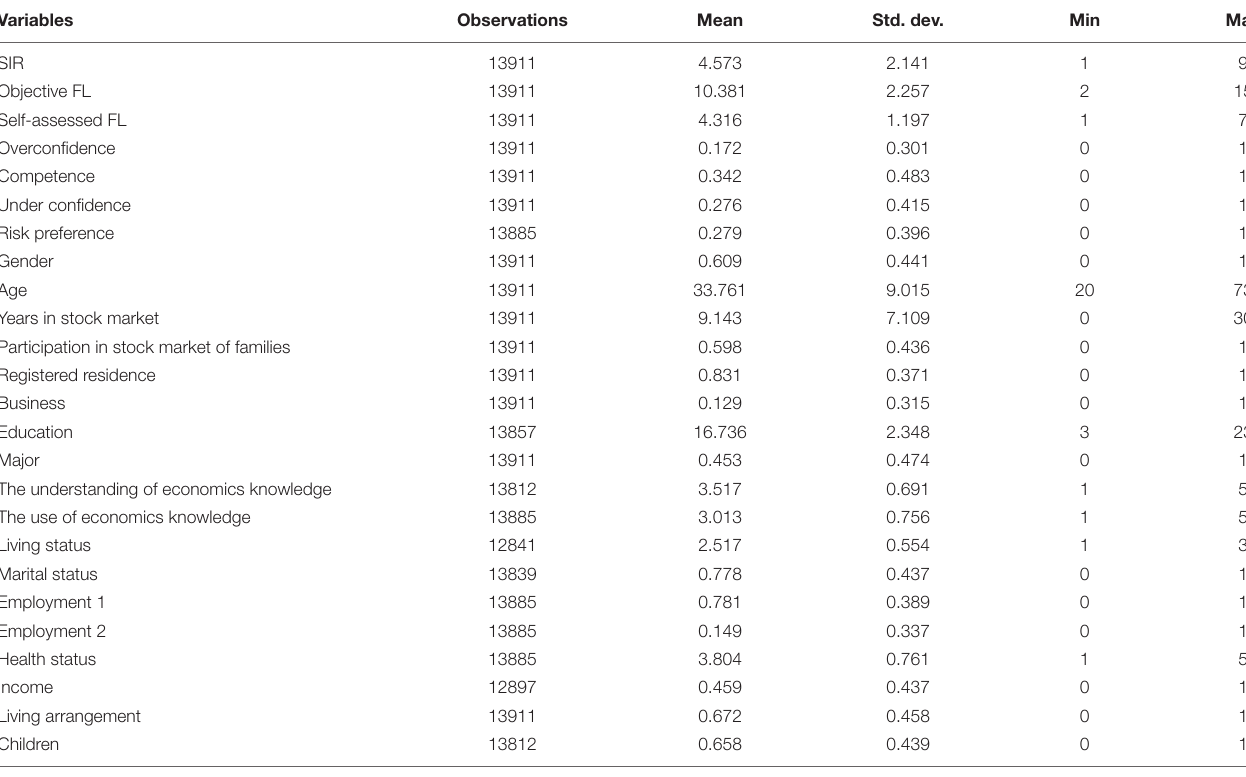
TABLE 5 | The descriptive statistics of variables.